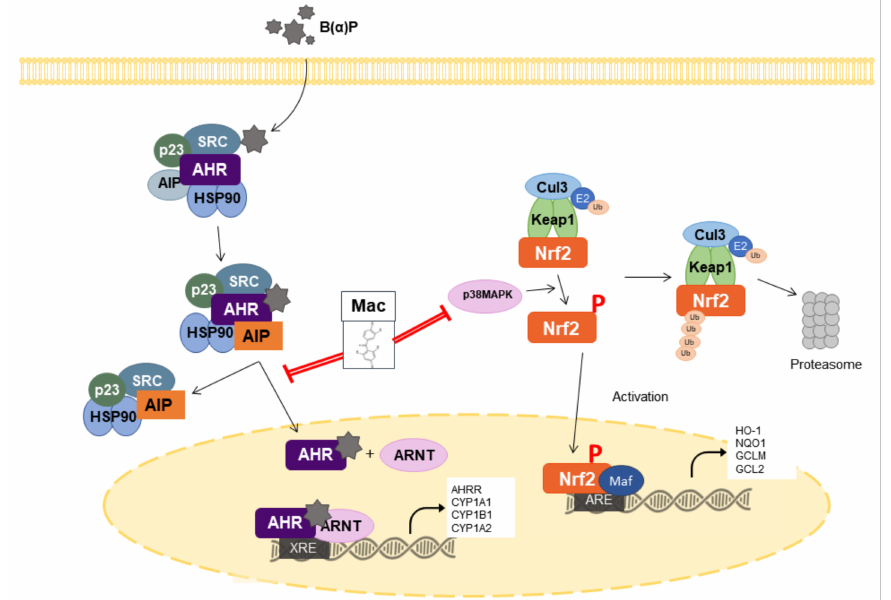
Figure 6. Action mechanism of maclurin in the AHR/Nrf2-mediated signaling. Maclurin inhibits B[a]P effects by inhibiting AHR through maintenance of the AHR-AIP complex and activating Nrf2 through p38 MAPK activation. Red line: Action step of